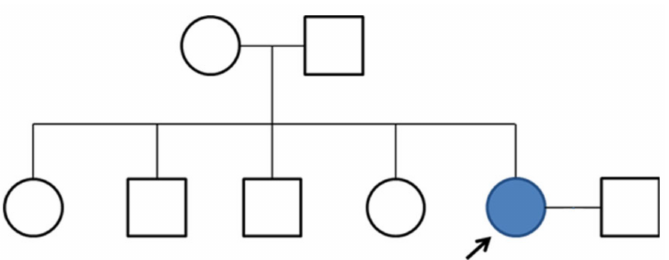
Figure 4. A family pedigree of the patient with Alzheimer’s disease, and a PS2 Gly56Ser mutation carrier is